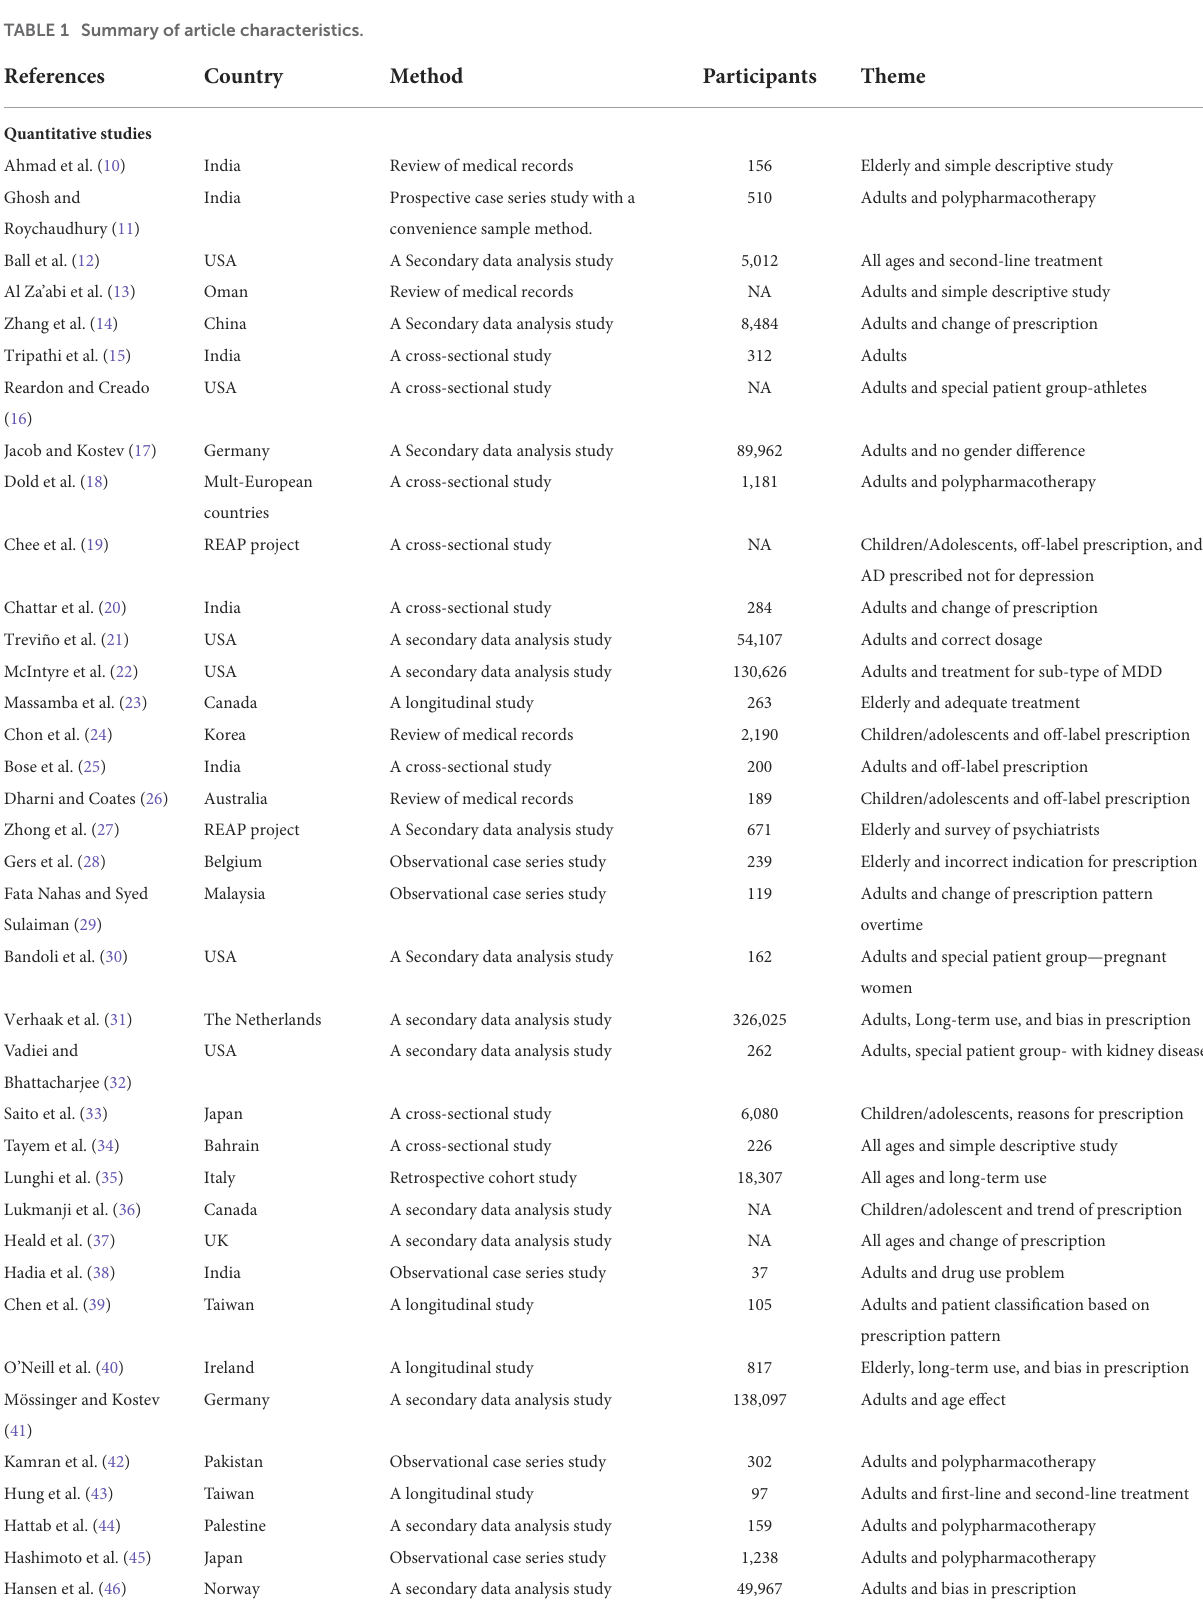
TABLE 1 Summary of article